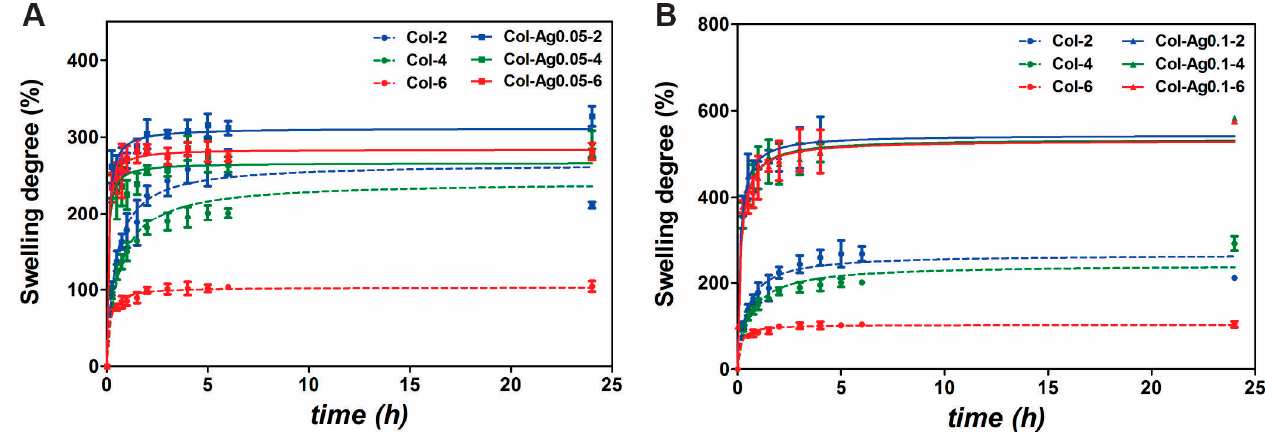
Figure 8. Swelling capacity of Col-Ag0.05 ( A ) and Col-Ag0.1 ( B ). Col-2(-- ● --blue), Col-4(-- ● -- green), Col-6 (-- ● --red), Col-Ag0.05-2 (- ■ -blue), Col-Ag0.05-4 (- ■ -green), Col-Ag0.05-6 (- ■ -red), Col-Ag0.05-2 (- ▲ -blue), Col-Ag0.05-4 (- ▲ -green), and Col-Ag0.05-6 (- ▲ -red). Results are ex- pressed as mean ± SD from triplicate